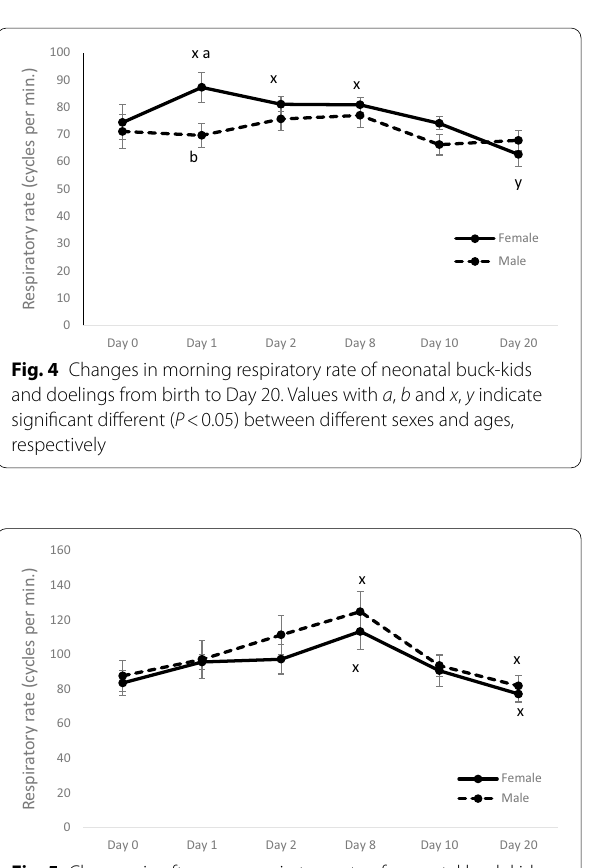
Fig. 5 Changes in afternoon respiratory rate of neonatal buck-kids and doelings from birth to Day 20. Values with a , b and x , y indicate significant different ( P < 0.05) between different